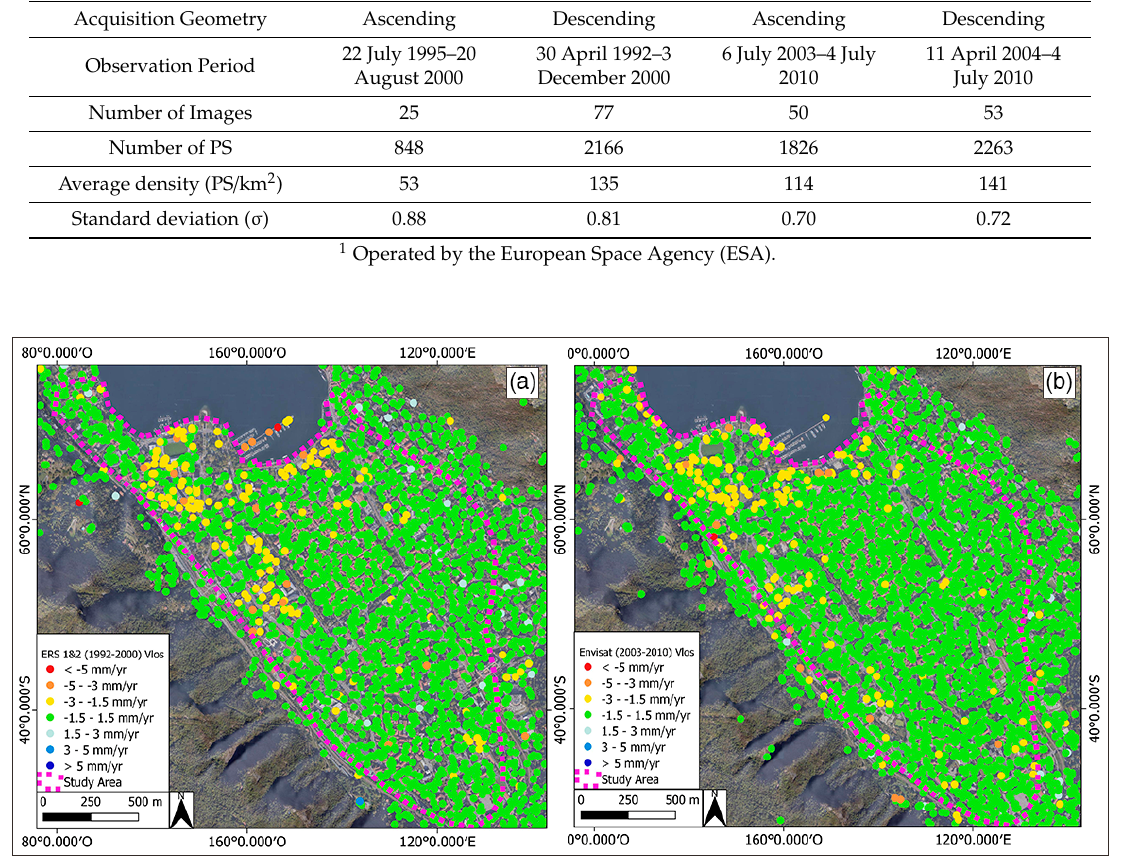
Figure 3. Persistent Scatterers (PS) classified according to the line of sight (LOS) velocity as